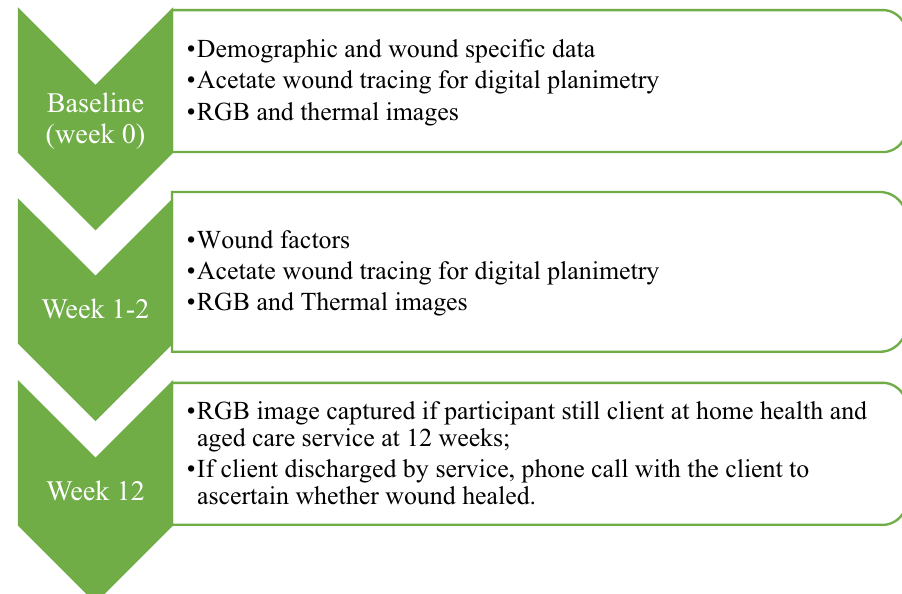
Figure 2. Flowchart of participant data collection.